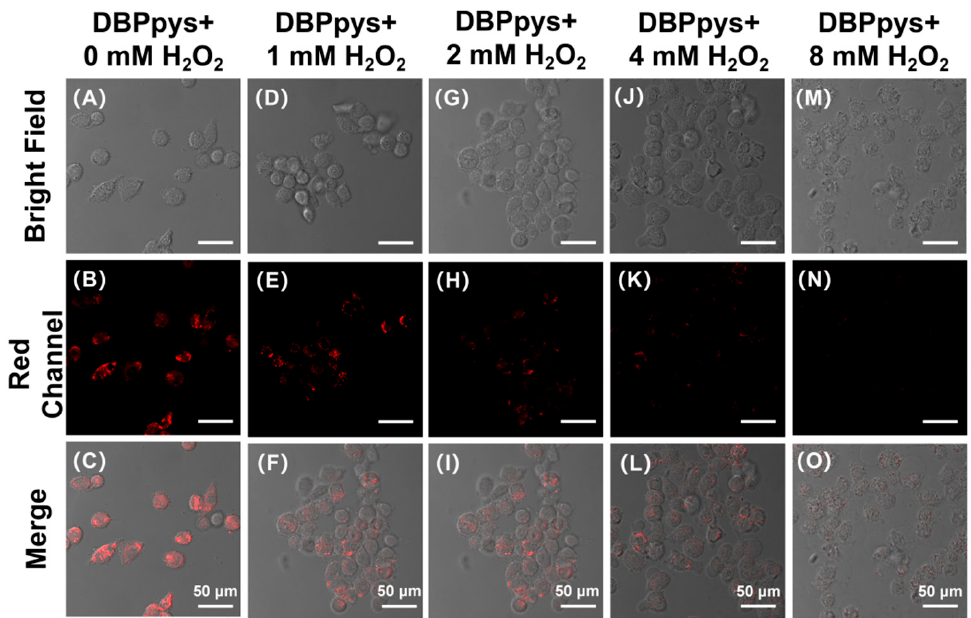
Figure 5. Fluorescent images of HeLa cells incubated with 10 µ M DBPpys for 60 min after pretreating with different amounts of H 2 O 2 for 2 h. H 2 O 2 concentrations: ( A – C ) 0 mM; ( D – F ) 1 mM; ( G – I ) 2 mM; ( J – L ) 4 mM; ( M – O) 8 mM. ( A , D , G , J , M ) bright field; ( B , E , H , K , N ) red channel (650–750 nm); ( C , F , I , L , O ) merge image. λ ex = 550 nm. Scale bar = 50 μ m.